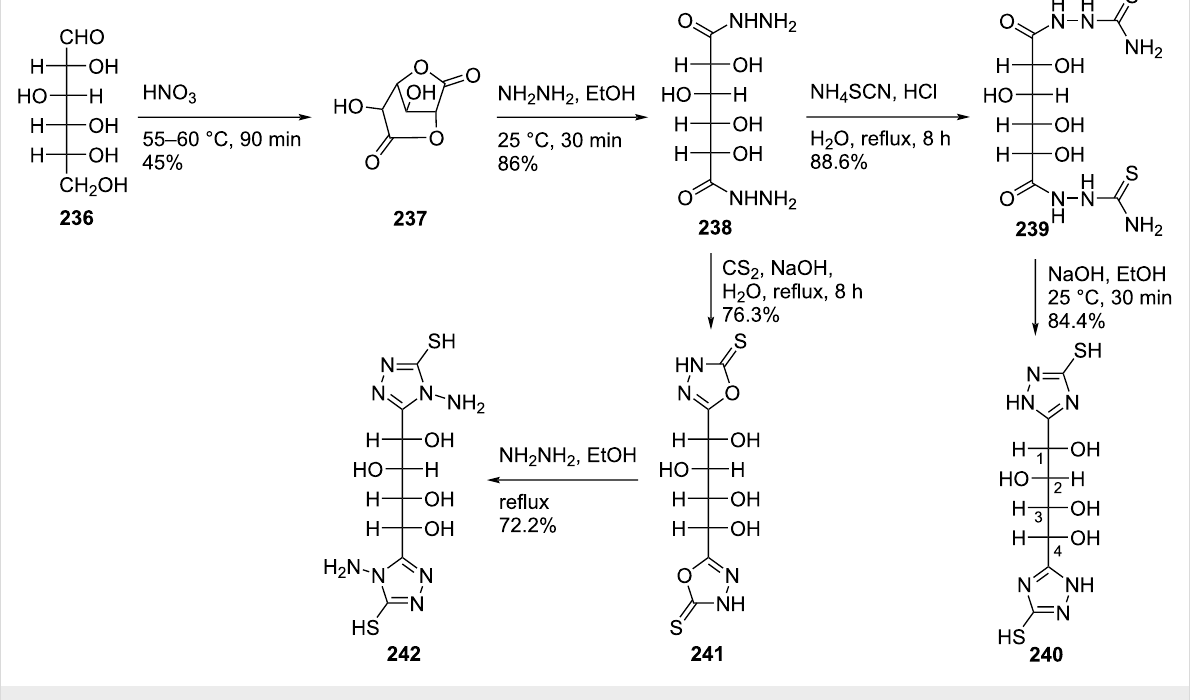
Scheme 63: Synthesis of double-headed acyclo C -nucleosides 240 – 242 .